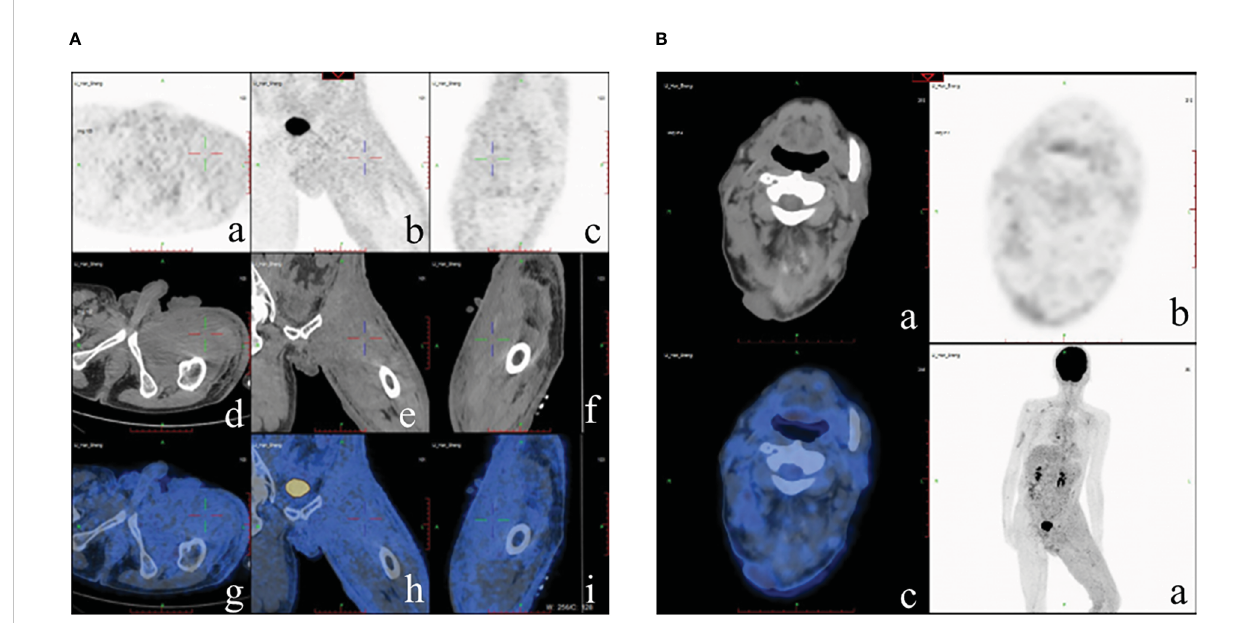
FIGURE 4 PET-CT examination. (A) Multiple humus-like hypodense nodules on the skin surface from the left groin to the thigh, secondary lymphedema, and slightly increased metabolic diffusion; (B) Localized thickening of the skin on the top of the left head and back of the neck and slightly increased